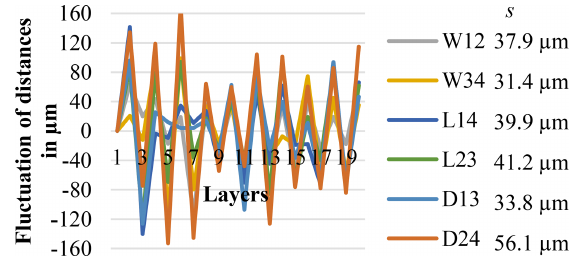
Figure 16. Fluctuation of determined distances of the reference pipes at process temperature ( ∼ 168 ◦ C) with the mechanical in- fluence of powder application in the x direction.